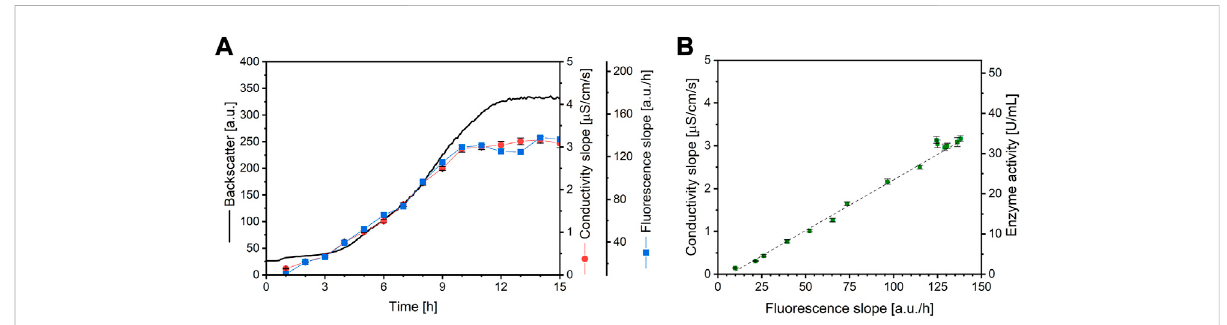
FIGURE 5 (A) Backscatter data (consistent line) from a microplate cultivation of S. pasteurii and urease activity data from standard conductivity measurements (red dots) as well as from the here established fl uorescence assay (blue squares) (B) Standard curve resulting from the correlation of both methods ( R 2 = 0.9914, N = 3). The error bars depict the standard deviation. As the correlation between conductivity slope and ammonium generation and therefore enzyme activity is known, the correlation between fl uorescence slope and enzyme activity is also known and be calculated with the equation y = 0.2643 x -